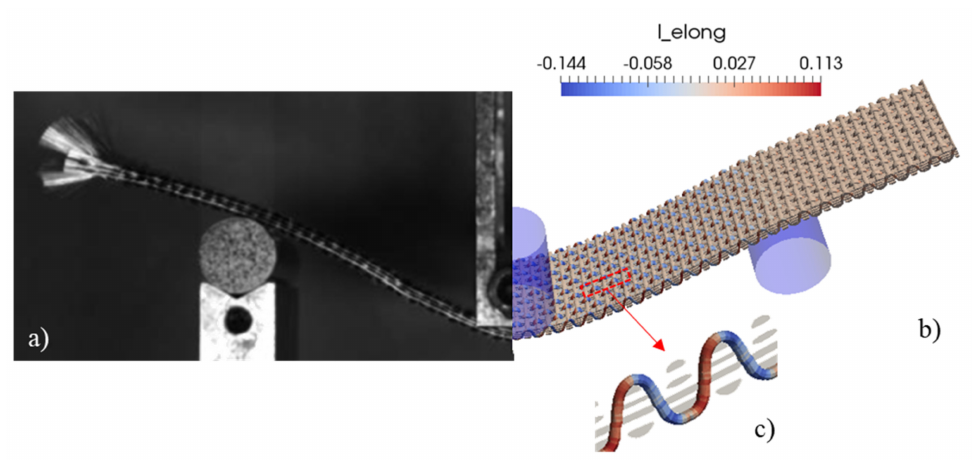
Figure 5. Three-point bending. ( a ) Deformed geometry in experimental result. ( b ) Elongation of yarns in mesoscopic analysis. ( c ) Elongation of an extracted yarn.